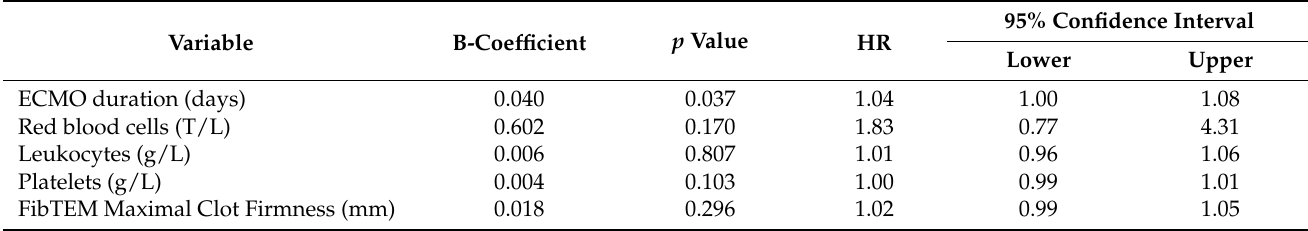
Table 5. Multivariate analysis: Identification of risk factors for thrombotic events (n =